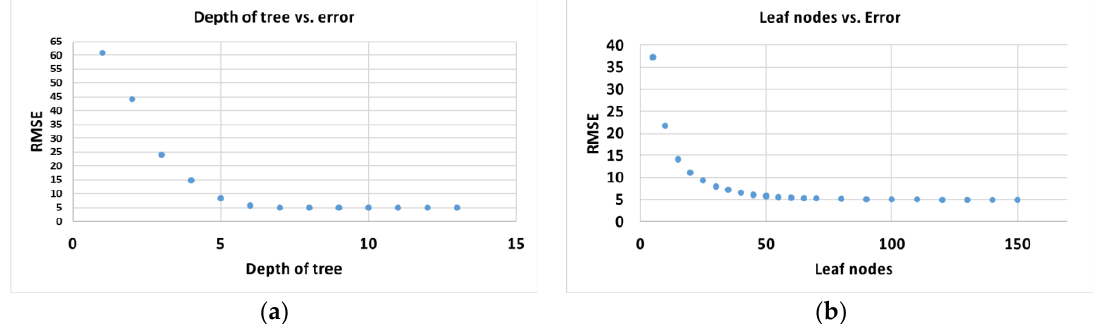
Figure 8. ( a ) RMSE vs. maximum depth of the tree and ( b ) RMSE vs. maximum leaf nodes.